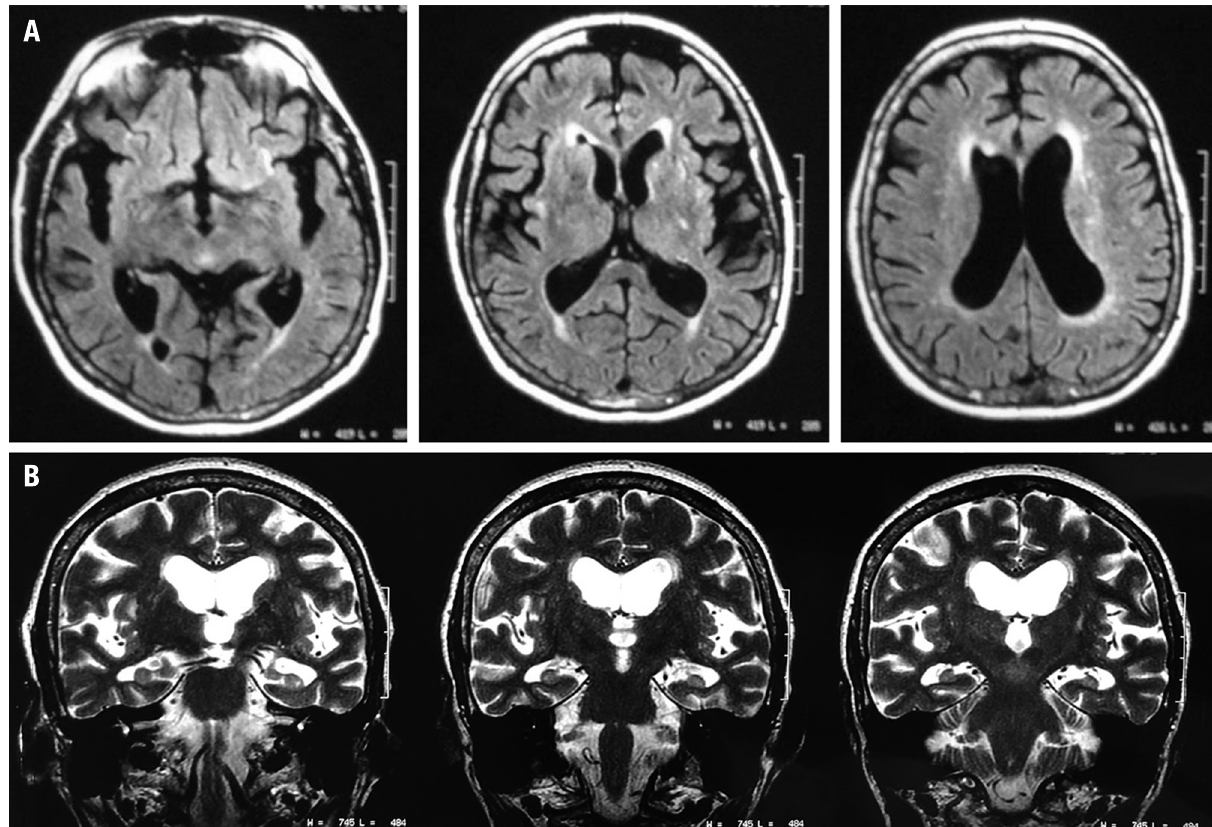
Figure 1. [A] Magnetic Resonance Imaging (MRI)* [B] Magnetic Resonance Imaging (MRI)**. *Axial Flair Brain MRI shows cortical atrophy with frontotemporal predominance and abnormal signal intensity in white matter suggestive of incipient ischemic microangiopathy. **Coronary slices show global atrophy with hippocampal